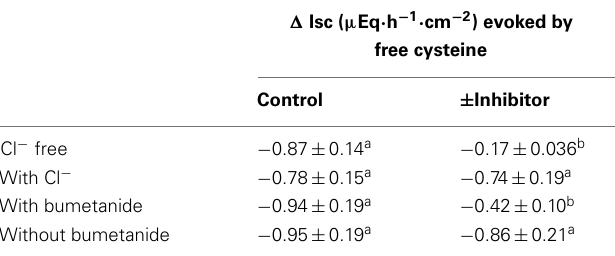
Table 2 | Effect of free cysteine after inhibition of Cl −